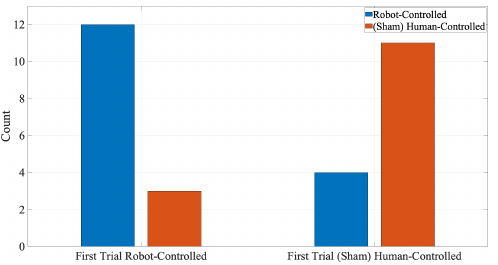
Figure 3. Cumulative (i.e., participants’ gender discarded) participants’ responses to